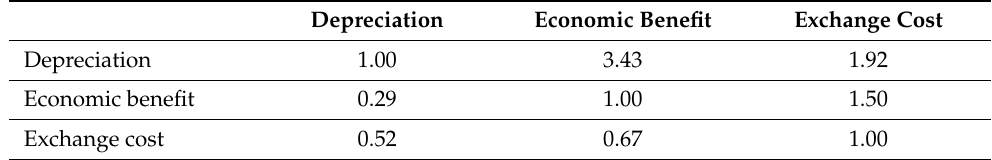
Table 3. Judgment matrix of revenue